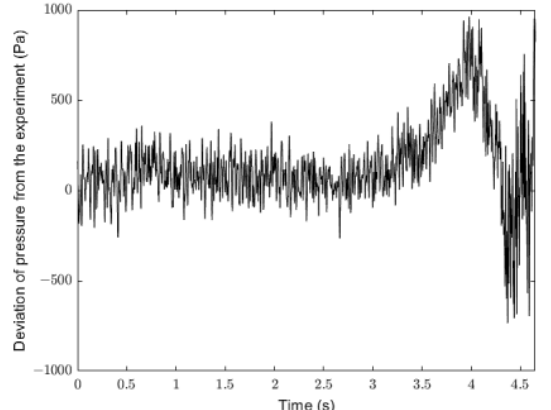
Figure 10. The deviation of estimated differential pressure by sliding mesh with the experiment between two cross-sections 11 m and 15 m upstream of the valve.